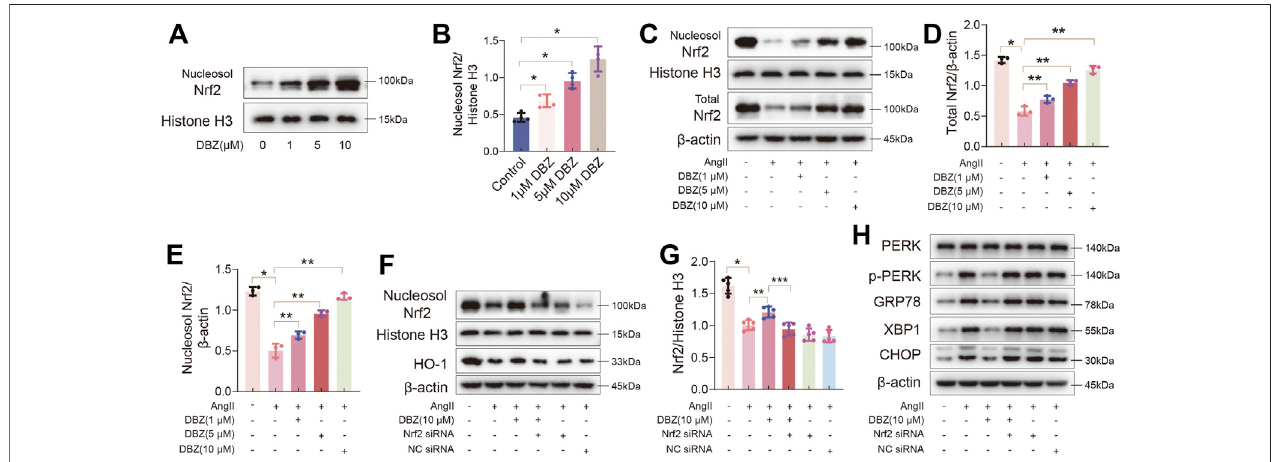
FIGURE 8 | Nrf2activationwascriticalfortheantioxidantandinhibitingERstressofDBZ. (A,B) RepresentativeWesternblottingassayandquanti fi cationofnucleosolNrf2 expression with DBZ treatment. n = 4. (C – E) Representative Western blotting assay and quanti fi cation of nucleosol and total Nrf2 expression. n = 3. (F,G) Cells transfected with Nrf2 siRNA or NCsiRNA, protein levels of nucleosol Nrf2were determined by Western blotting assay and quanti fi ed by densitometry. n = 5. (H) RepresentativeWestern blotting assayofPERK,p-PERK,GRP78,XBP1andCHOPexpression.* p < .05comparedwiththeControlgroup,** p < .05comparedwiththeAngIIgroup,*** p < .05compared with the Ang II + DBZ group. Results are expressed as means ± SD. Statistical analyses were performed by one-way ANOVA followed by Bonferroni ’ s post-hoc test.